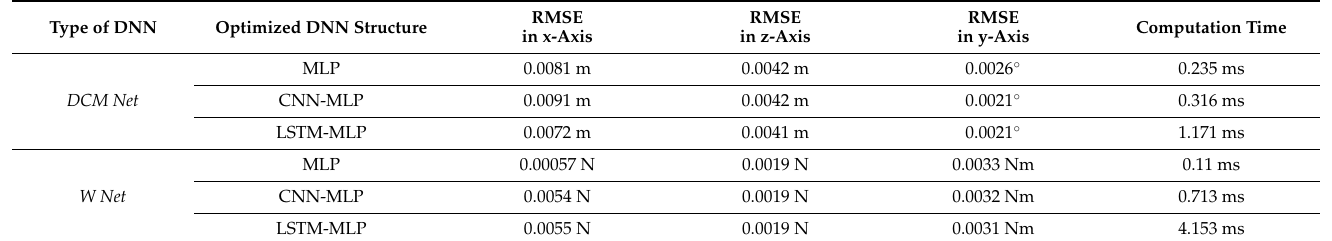
Table 2. Performance of Three Optimized DNN Structures for DCM Net and W Net of the Robot Simulator.